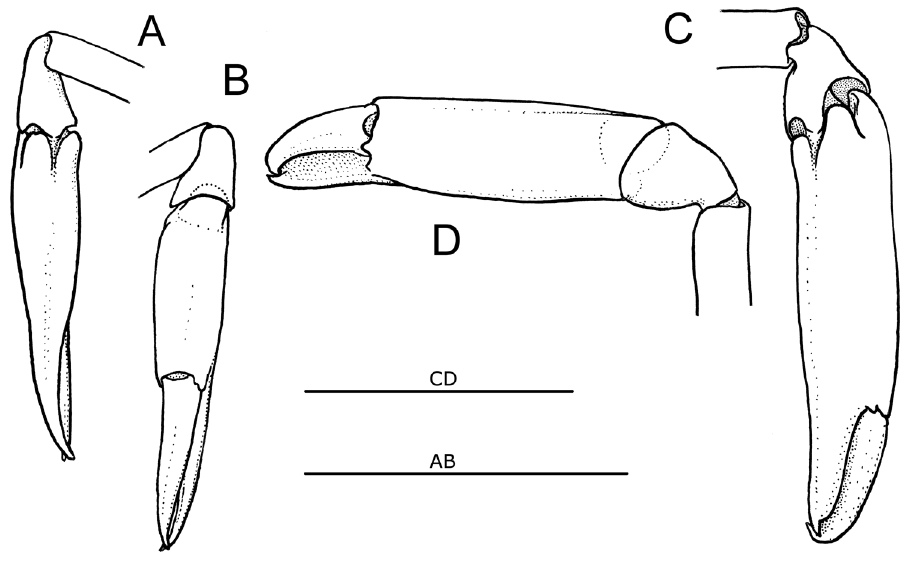
Figure 2. Second pereiopod of species of the genus Cristimanus gen. n. showing specific carpo-propodal articulation. A, B Cristimenes commensalis (Borradaile, 1915), comb. n., MTQ 33230, Lizard Island, Great Barrier Reef C, D Cristimenes cristimanus (Bruce, 1965), comb. n., UO 103-Vn08, Nhatrang Bay, Vietnam. ( A, C medial aspect; B, D lateral aspect; scale bars 1